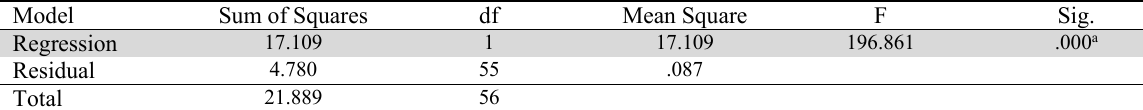
The results of the ANOVA test